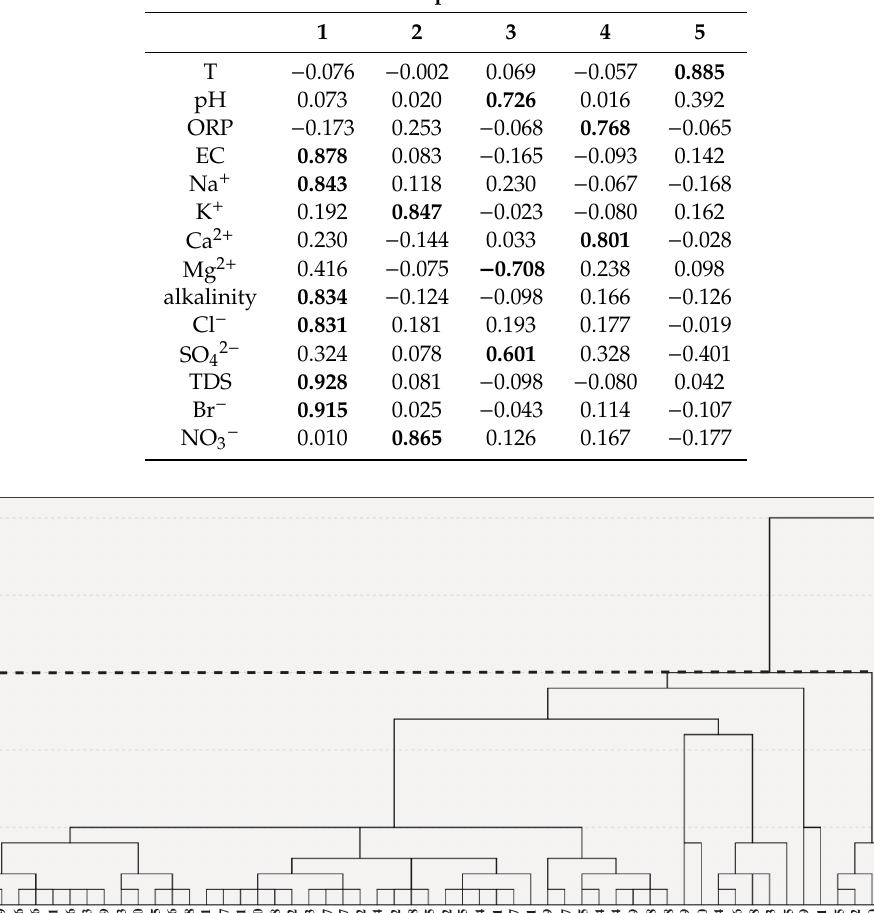
Figure 7. Dendrogram from hierarchical cluster analysis